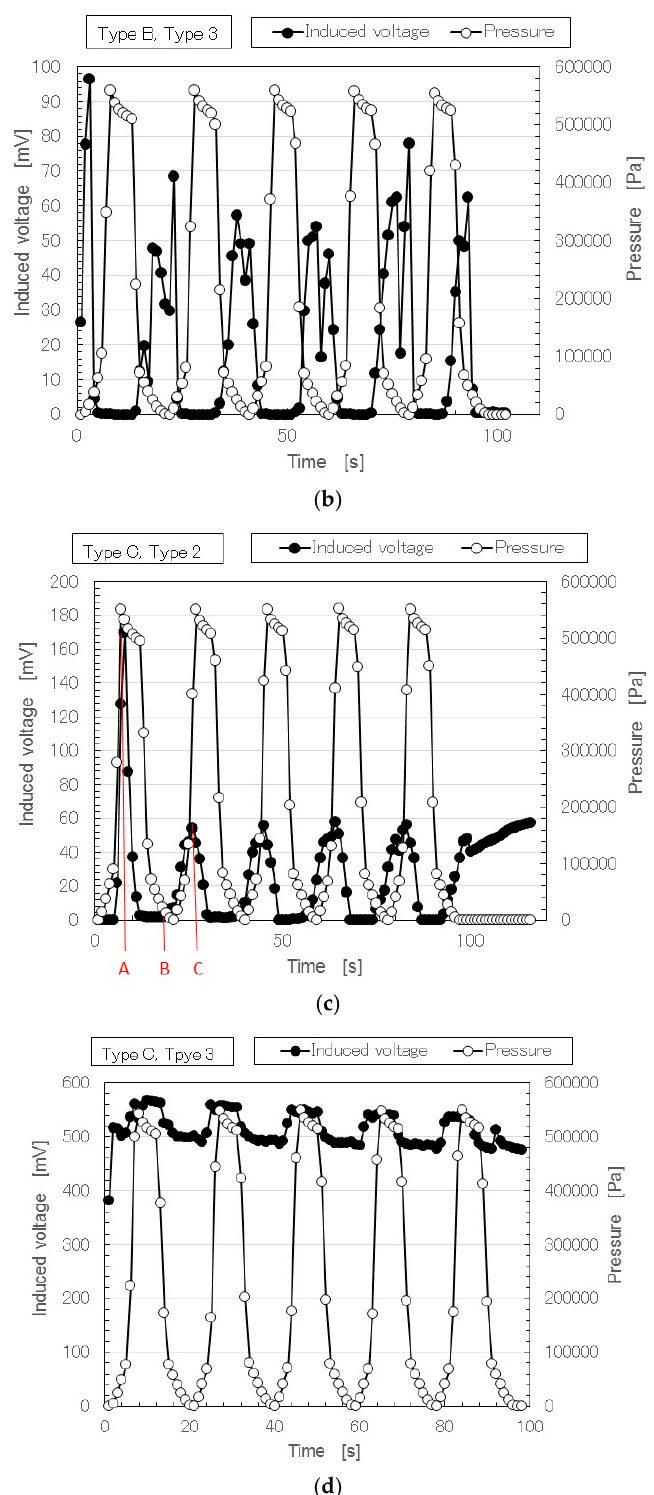
Figure 5. Typical results of time-lapse of the induced voltage and the pressure in the cases of Types 2, 3 and B, C. ( a ) Type B and 2; ( b ) Type B and 3; ( c ) Type C and 2; ( d ) Type C and 3.